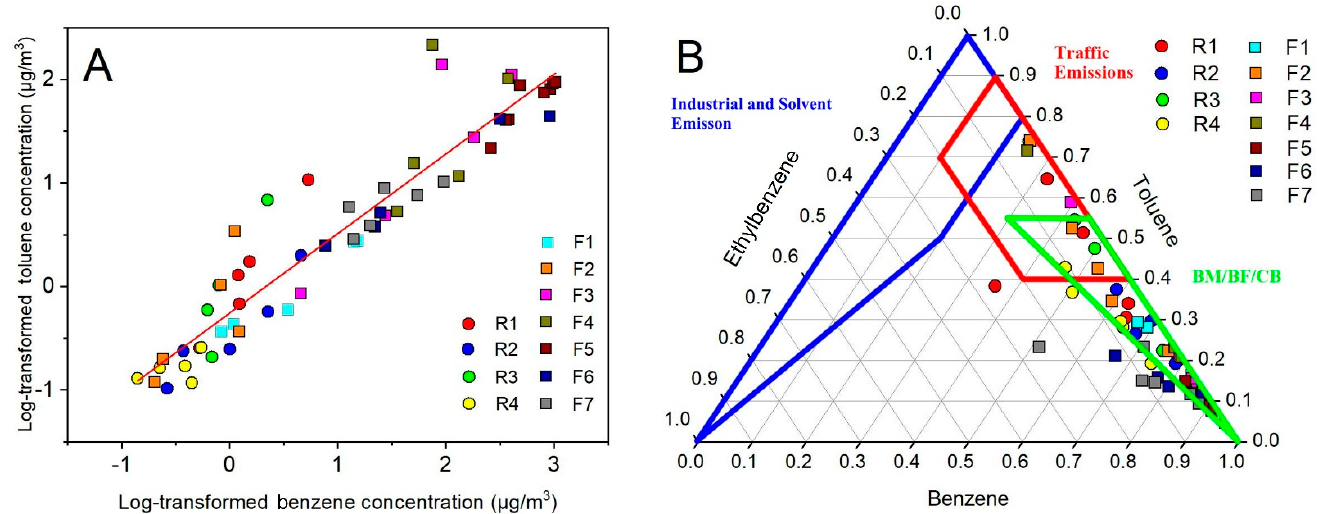
Figure 4. ( A ) Correlation between benzene and toluene and ( B ) source apportionment of BTEX from eleven sampling sites. Areas in green, blue and red outlines are profiles of biomass/biofuel/coal burning (BM/BF/CB), industrial and solvent emissions and traffic emissions, respectively.